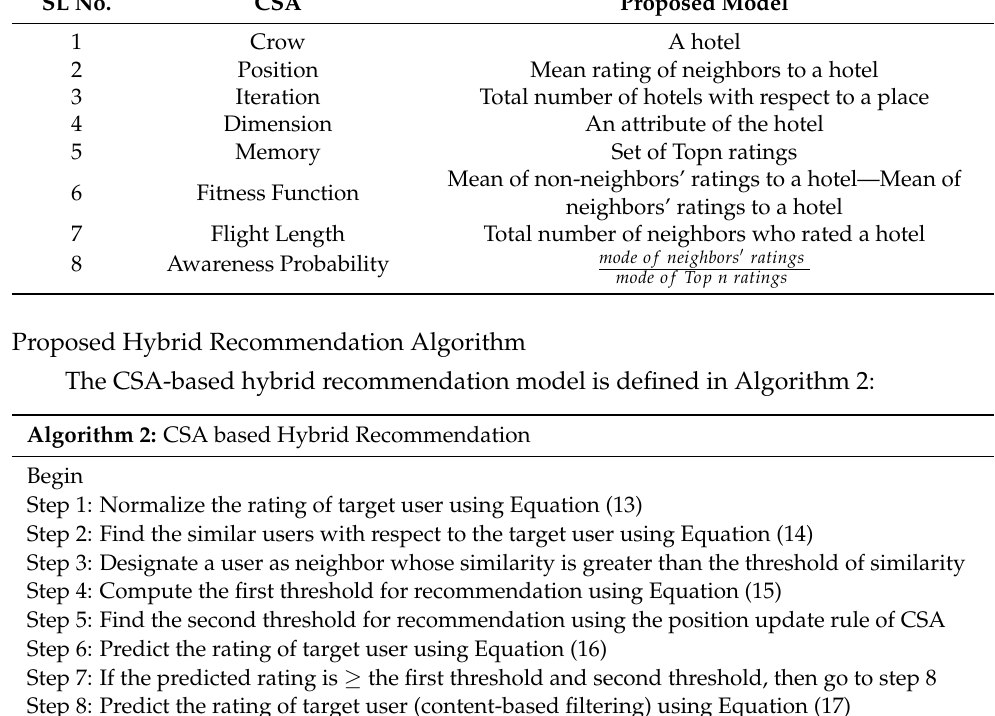
Table 1. Analogy between the parameters of CSA and parameters of the proposed model. SL No.